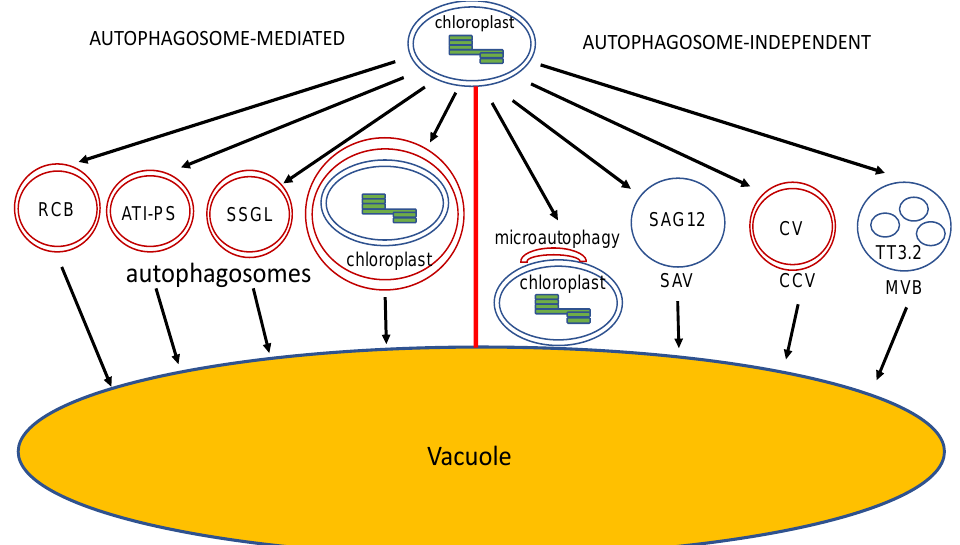
Figure 4. Diverse pathways for vesicle-mediated vacuolar degradation of chloroplasts and chloroplast components. Some of the pathways for degradation of chloroplast components are mediated by autophagosome-derived vesicles such as RCBs, ATI – PS and SSGL bodies. Whole chloroplasts can also be delivered by autophagosomes to the vacuole for degradation. Damaged chloroplasts can also be degraded in the vacuole by microautophagy in which the chloroplasts are isolated and delivered to the vacuole through direct enclosing. Chloroplast components can be delivered by vesicles other than autophagosomes to the vacuole for degradation. These vesicles include SAVs, CCVs and MVBs.